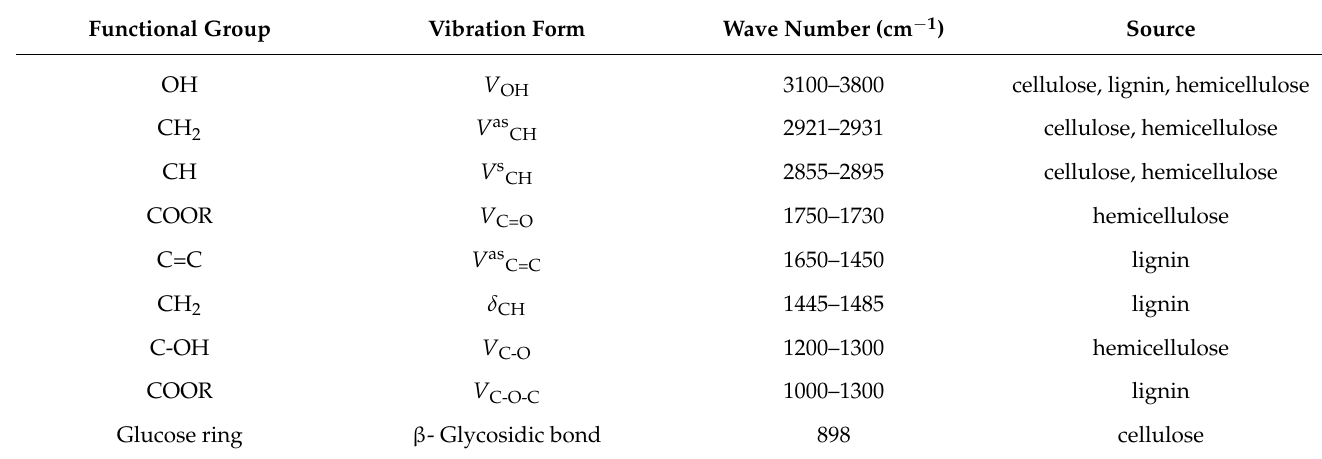
Figure 10. Spectrum of banana fibre ( a ) 5 days of retting with warm water; ( b ) 15 days of retting with warm water; ( c ) 25 days of retting with warm water. Table 4. Corresponding peak positions and sources of functional groups in fibres